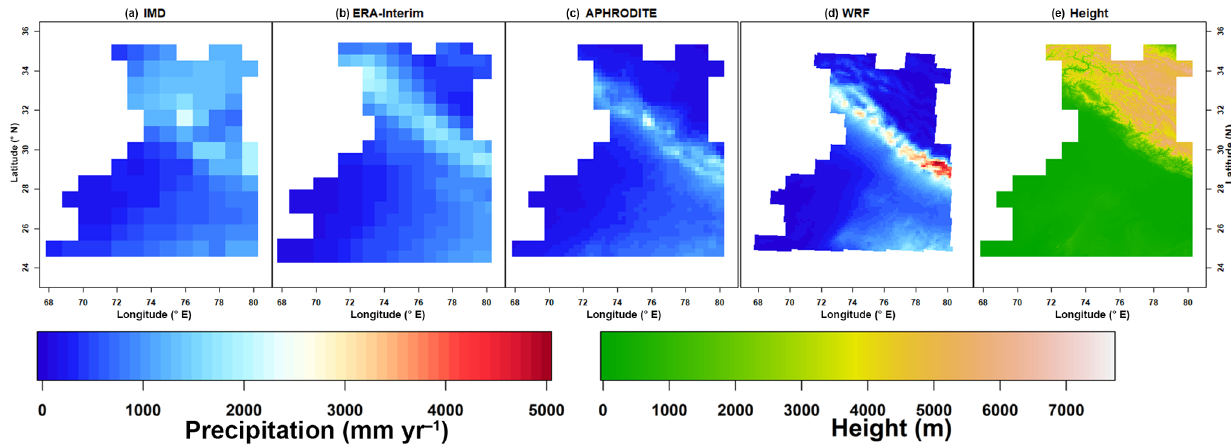
Figure 2. Mean annual precipitation (1981–2007) of the four datasets (from a IMD gridded observations, ERA-Interim reanalysis, APHRODITE gridded observations and WRF regional climate model simulation) and terrain height of the study area (e) .